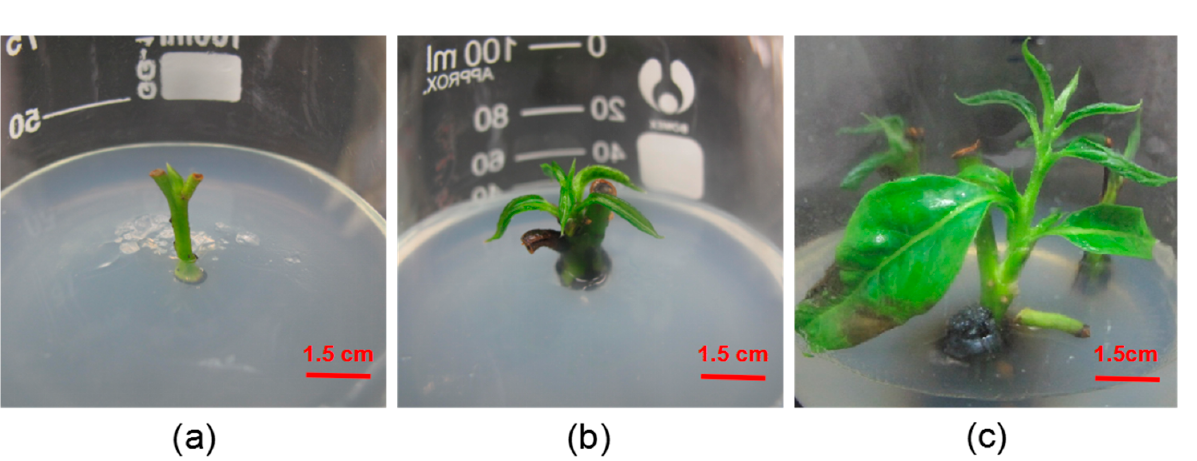
Means followed by the same letters in rows are not significantly different at p ≤ 0.05. The values in brackets are the real statistical data with the decimal point removed. brackets are the real statistical data with the decimal point removed.